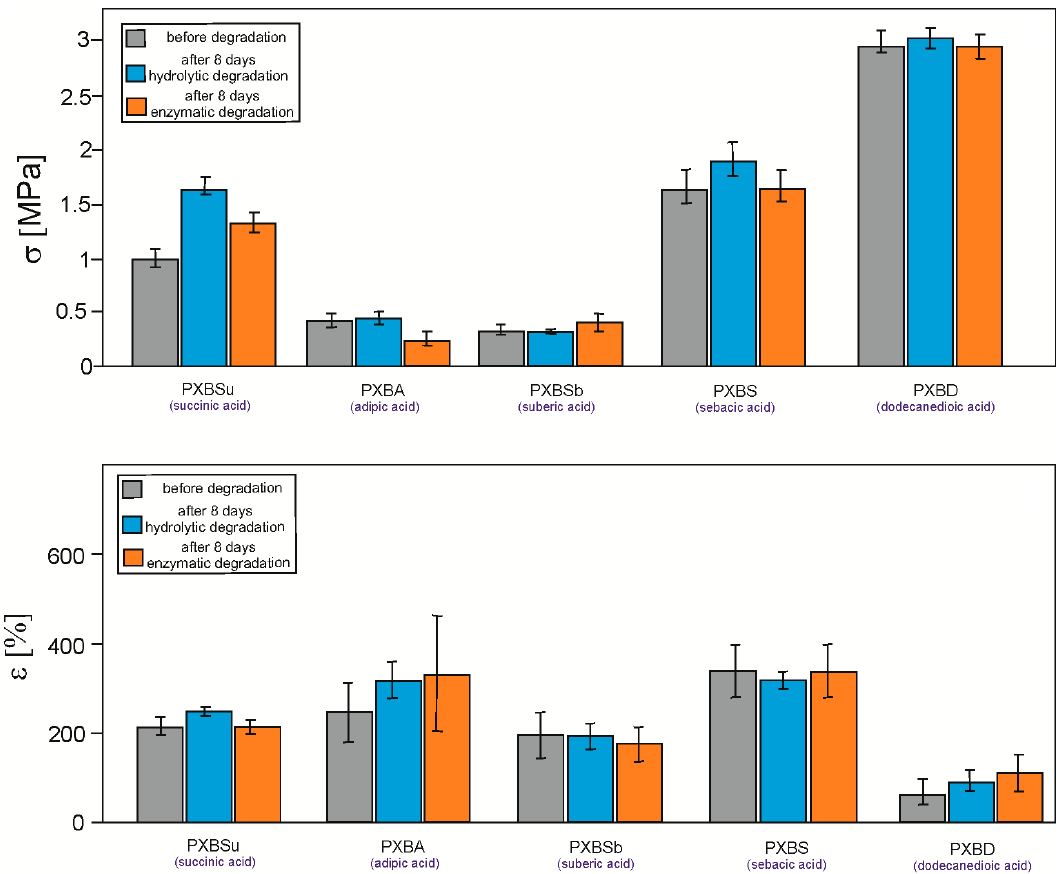
Figure 11. Mechanical properties of PXBSu, PXBA, PXBSb, PXBS and PXBD polymers.